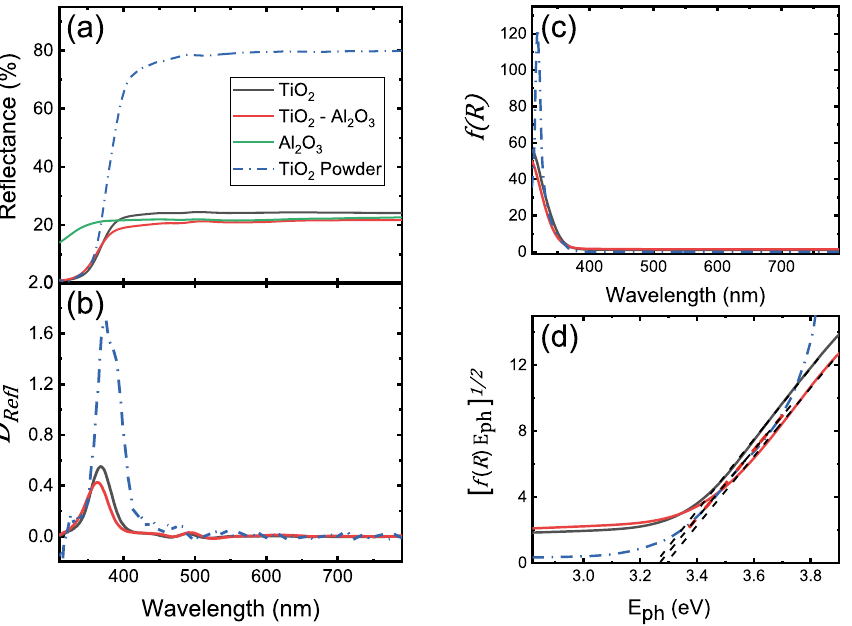
Figure 5. ( a ) Diffuse reflectance of TiO 2 , TiO 2 –Al 2 O 3 and Al 2 O 3 nanoparticles embedded in LDPE from 310 nm to 790 nm. The blue dashed-dot line denotes the diffuse reflectance of TiO 2 granulated powder. ( b ) The first derivative of the diffuse reflectance of TiO 2 , TiO 2 –Al 2 O 3 films and TiO 2 granulated powder. ( c ) Kubelka–Munk function for each material. ( d ) Tauc plot of the reflectance spectrum with linear fits (black dashed lines) for each material. The horizontal axis intersection point of each linear fit denotes the corresponding energy band gap E g